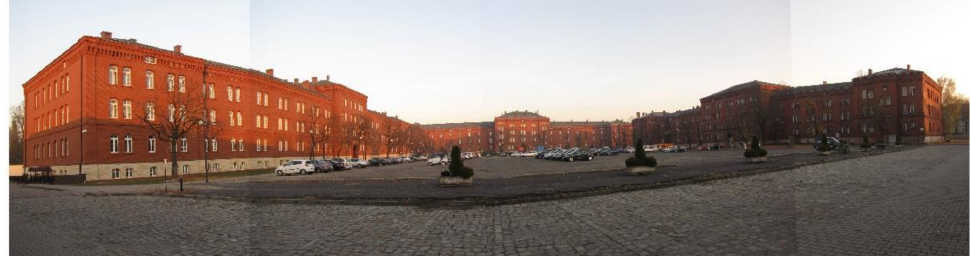
Figure 7. A view of the training grounds in the courtyard of the Grenadier barracks with the southernmost buildings on the right (photo by M. Rudnicka-Bogusz).